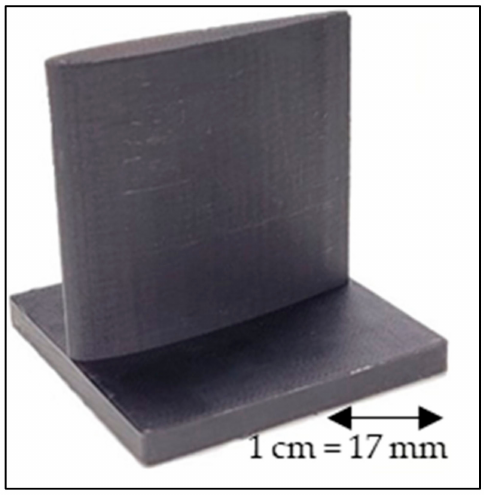
Figure 5. NACA 63-015-inspired smooth 3D-printed